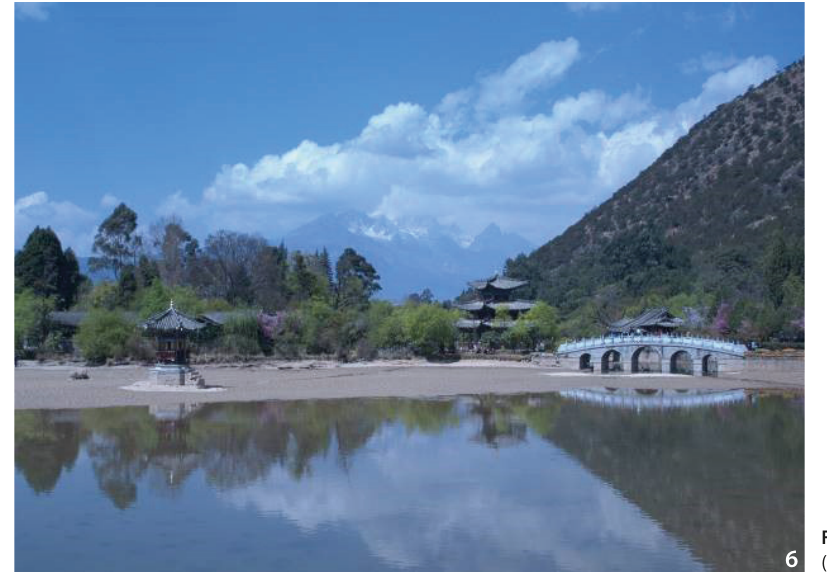
Figure 6 Heilong pool is almost dried up in 2012 (Source: the author).